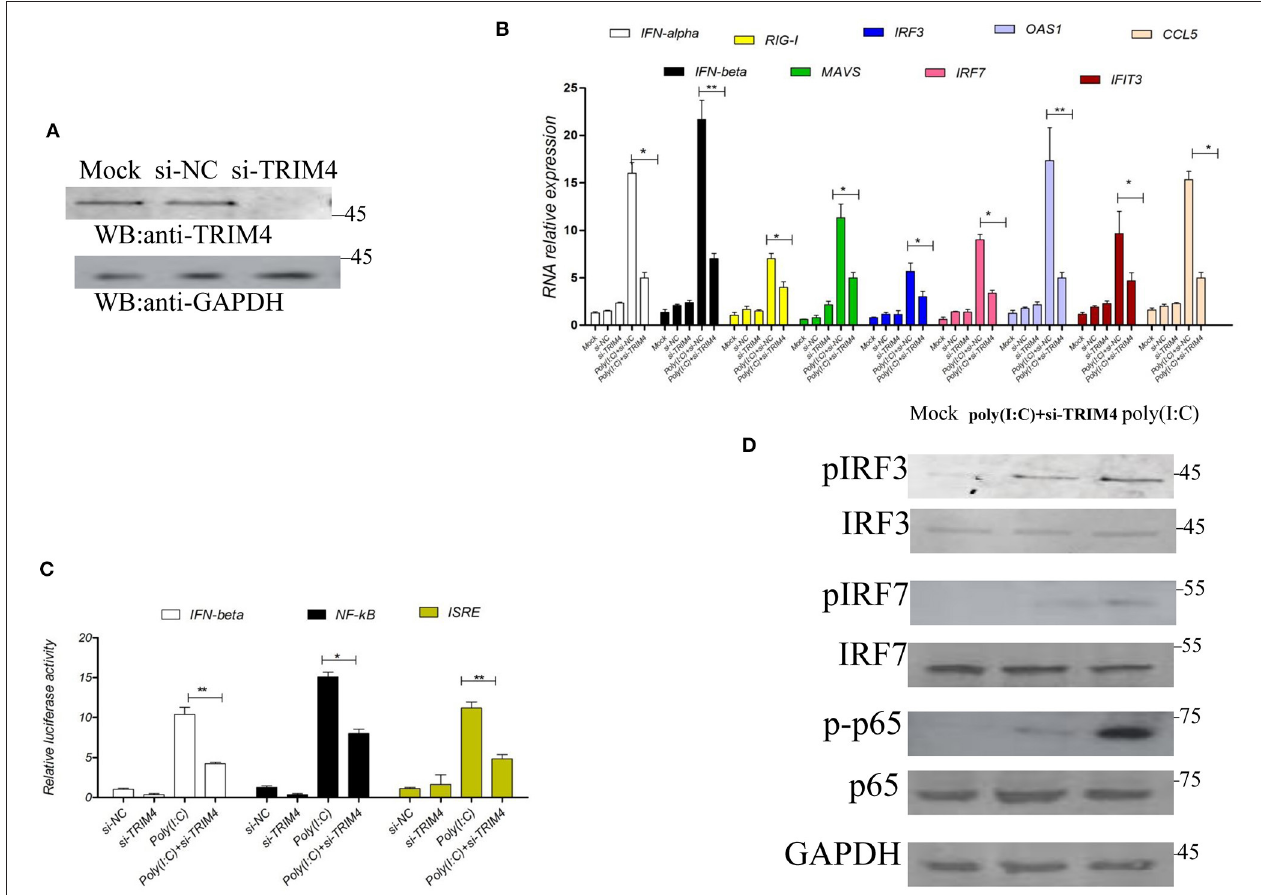
FIGURE 2 | Macaca mulata TRIM4 siRNA inhibits the IFN pathway. (A) The qPCR was used to determine the knockdown efficiency of TRIM4 siRNA. TRIM4 siRNA (60nM) was transfected into MARC145 cells. After 48h, the expression of TRIM4 in MARC145 cells was determined by western blotting. (B) The effect of TRIM4 siRNA on IFN-beta and CCL5 mRNA levels. TRIM4 siRNA (60nM) was transfected into MARC145 cells, after 24h, 1.0 µ g/mL poly(I:C) was transfected, the changes of IFN-alpha, IFN-beta, RIG-I, MAVS, IRF3, IRF7, OAS1, IFIT3, and CCL5 mRNA expression in MARC145 cells were determined by qPCR at 9h post-transfection. (C) The effect of TRIM4 siRNA on the activity of IFN-beta, NF- κ B, and ISRE promoters. TRIM4 siRNA (60nM), IFN-beta reporter plasmid (200 ng), NF- κ B reporter plasmid, ISRE reporter plasmid, and 50 ng of RL-TK plasmid were transfected into MARC145 cells. After 24h, 1.0 µ g/mL poly(I:C) was transfected, and the activity of the reporter was detected by a reporter test at 9h post-transfection. (D) TRIM4 siRNA downregulates the phosphorylated levels of interferon-related molecules. The si-TRIM4 (60nM) were transfected into MARC145 cells in a 24-well plate, after 24h post-transfection, 1.0 µ g/mL poly(I:C) was transfected, cell lysates were blotted with the indicated antibodies. * P < 0.05; ** P <